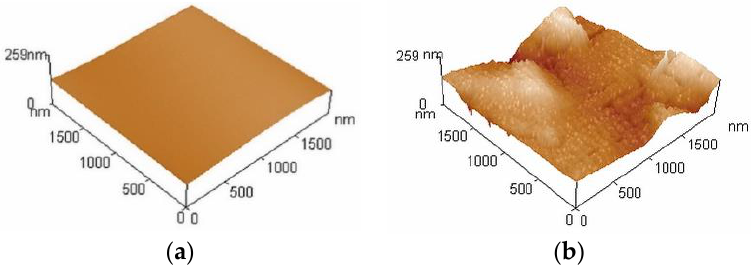
Figure 3. Scanning probe microscopy (SPM) analysis of basalt fibres: ( a ) un-sized fibre (Basalt 1), and ( b ) plasma-treated fibre (Basalt 11).